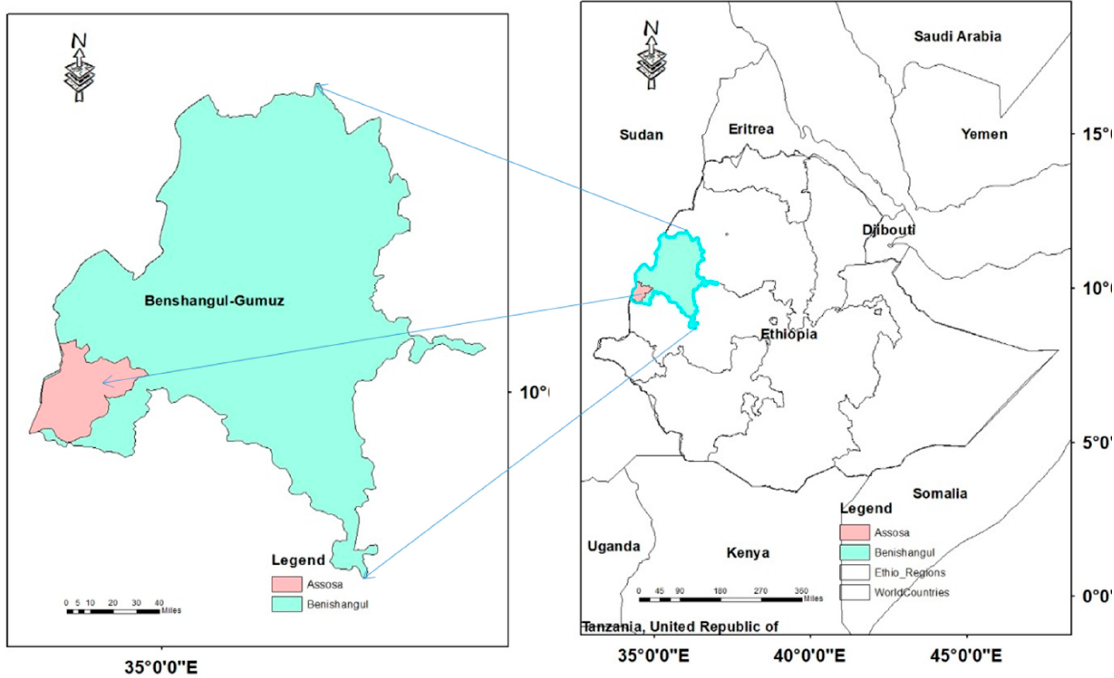
Figure 1. Location of Assosa district in western Ethiopia.